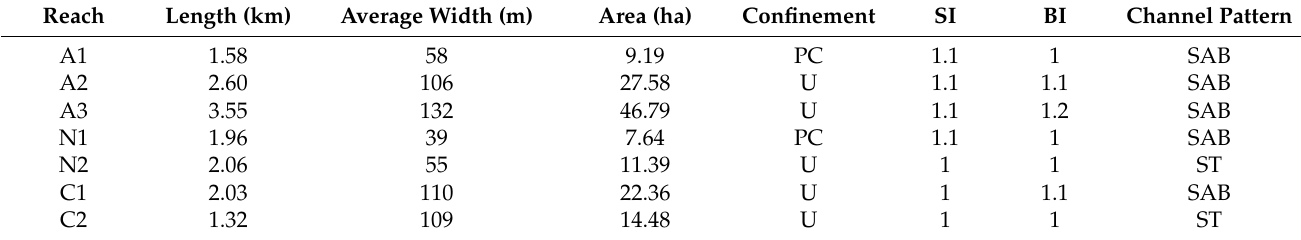
Table 3. Main morphological features of identified reaches referred to the 2020 active channel. The sinuosity index (SI) and braiding index (BI) are dimensionless parameters. PC: partly confined; U: unconfined; SAB: sinuous with alternate bars; ST: